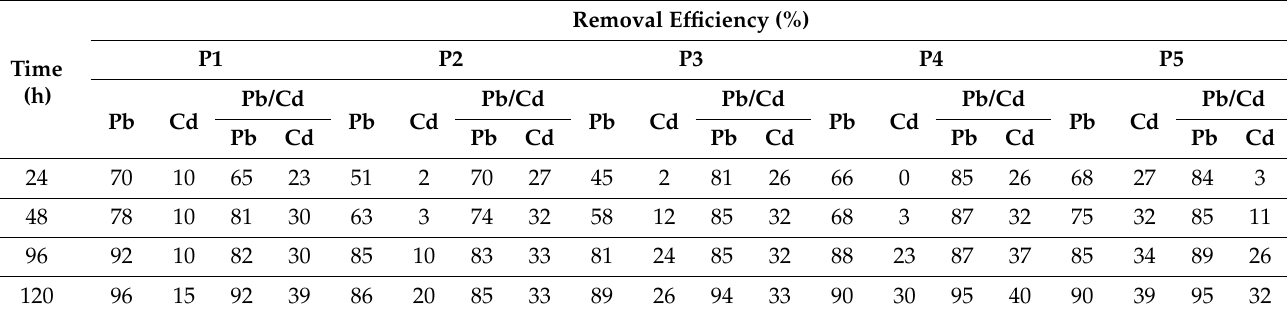
Table 3. Efficiency of heavy metals’